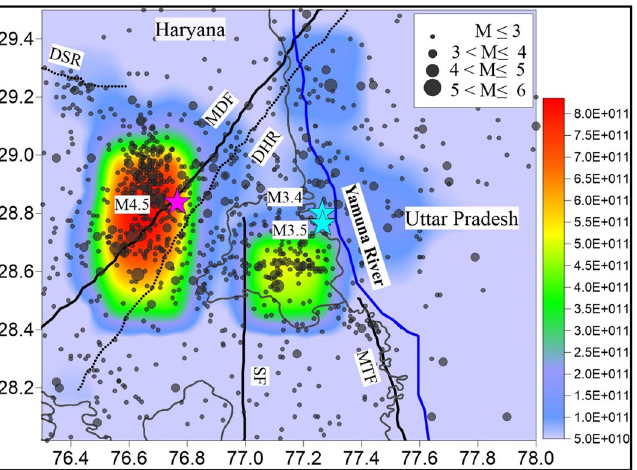
Figure 4. Distribution of estimated seismic energy release from earthquakes during 1998-April 2020 in the Delhi region considering a 0.3° × 0.3° grid. The tectonic features are from the files provided at BHUKOSH portal of the Geological Survey of India (http:// bhuko sh. gsi. gov. in/ Bhuko sh/ MapVi ewer.